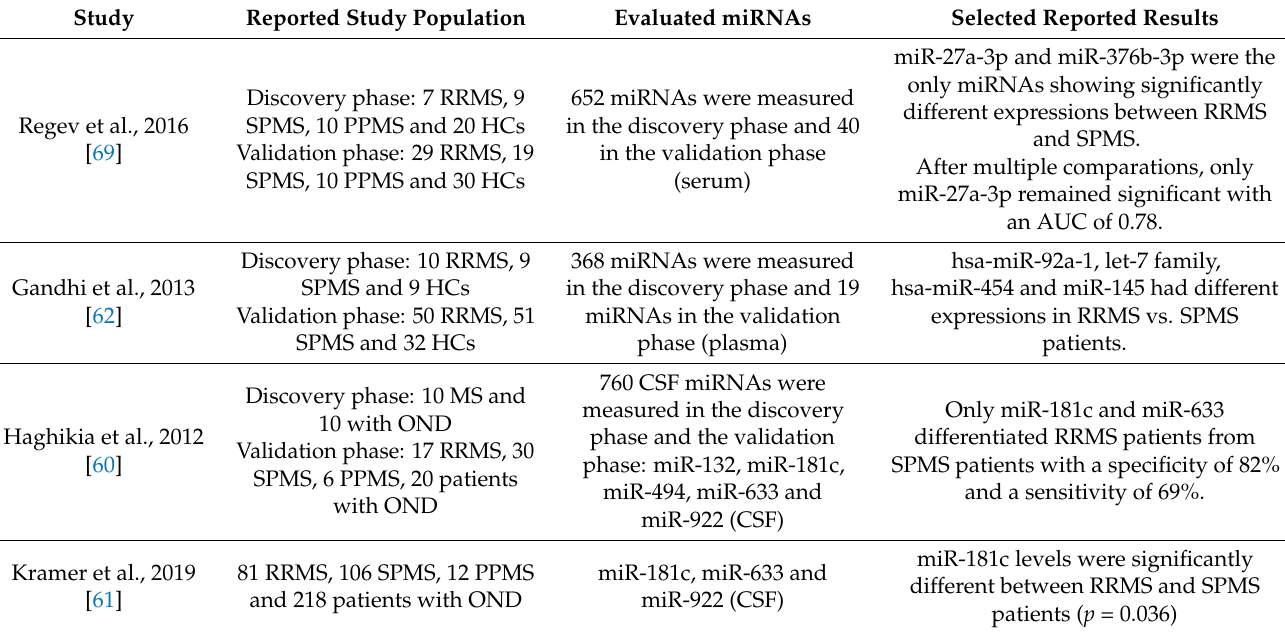
Table 1. Selected studies regarding miRNAs’ role as biomarkers for differentiating RRMS and SPMS